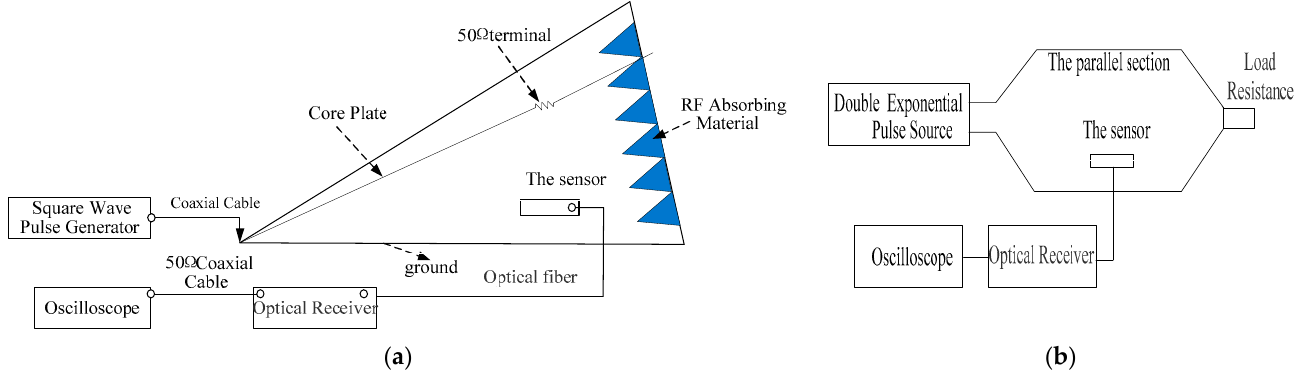
Sensors 2021 , 21 , x FOR PEER REVIEW 13 of 15